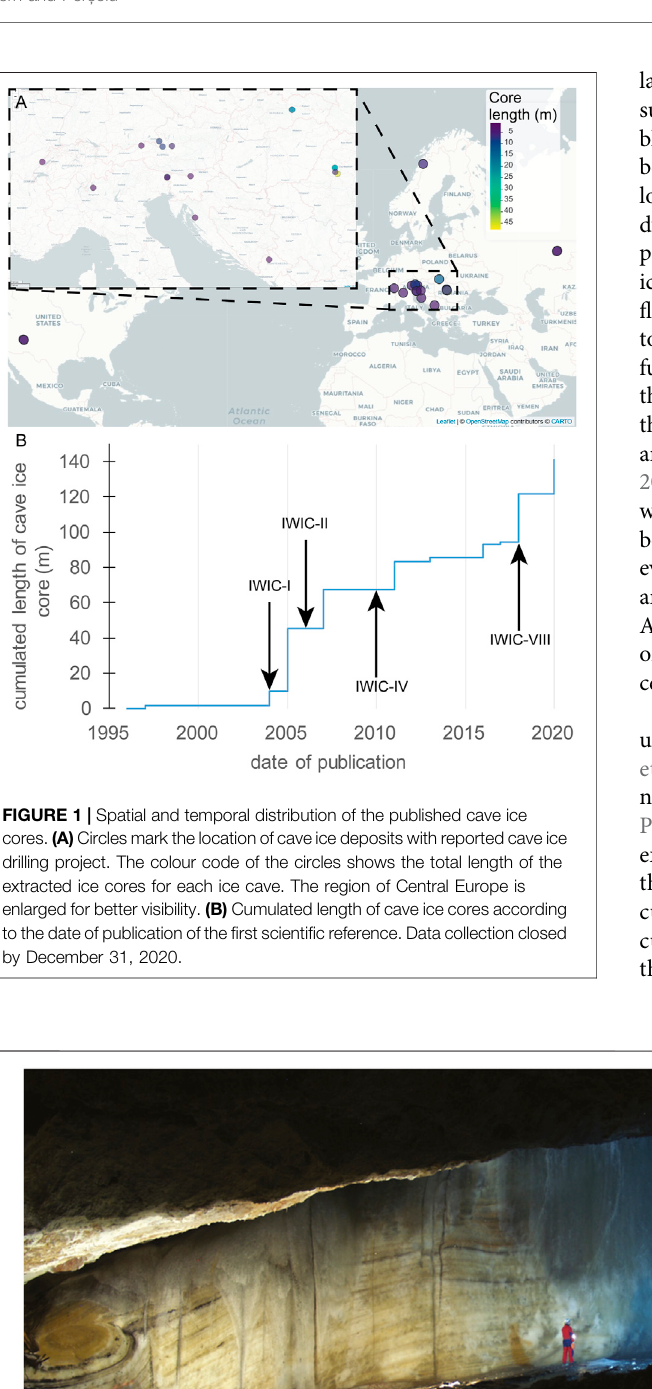
Frontiers in Earth Science |